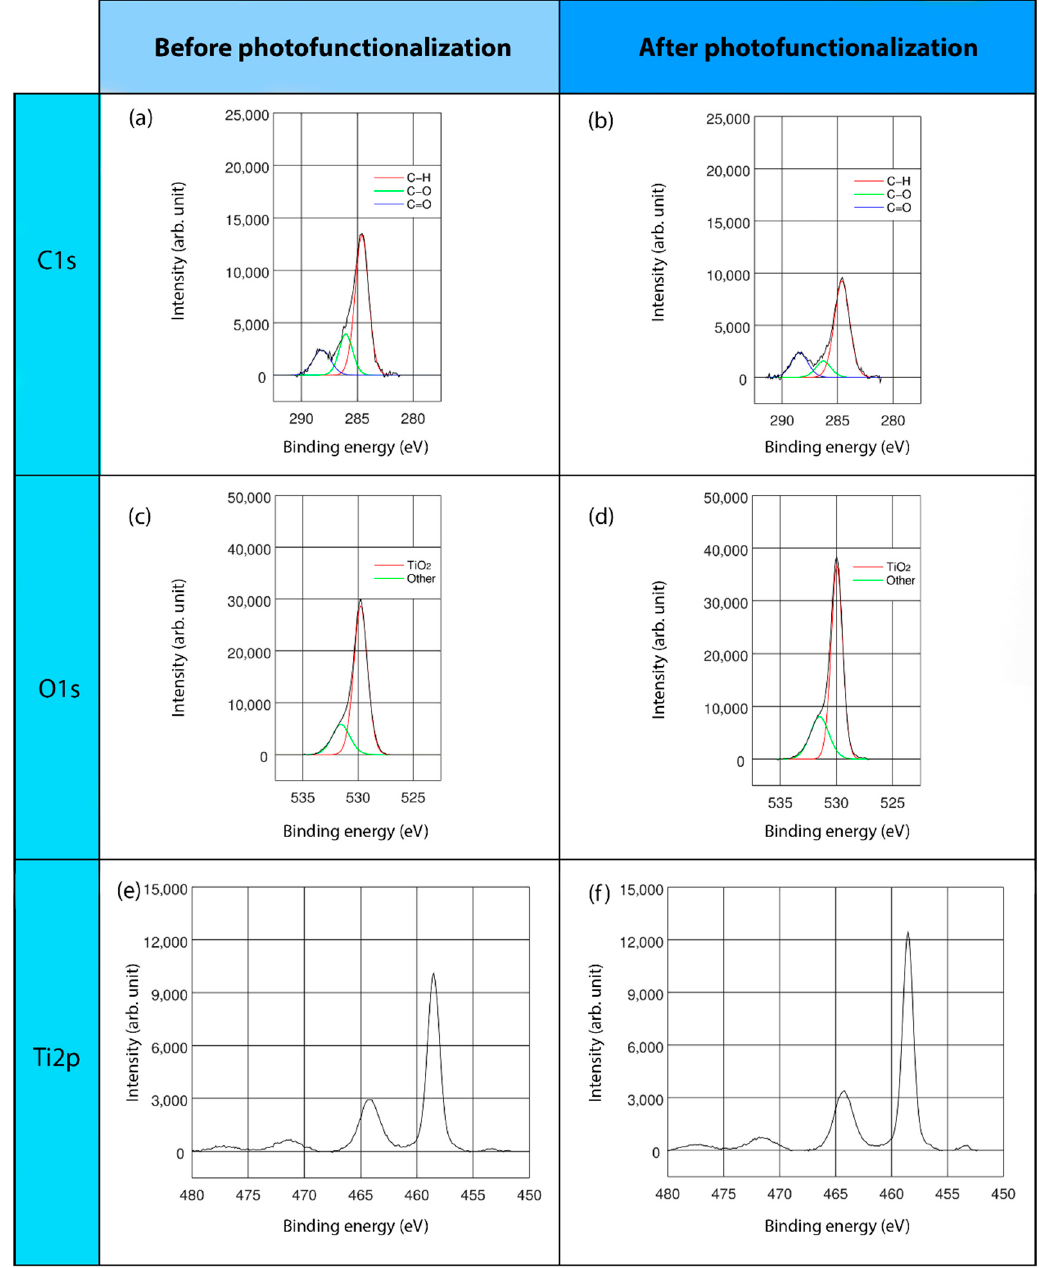
Figure 4. XPS analyses of SLA surface: XPS full-range spectra and deconvoluted XPS, with lines analysis and binding energies of C1s, O1s, and Ti2p; before ( a , c , e ) and after ( b , d , f ) LED-based UVC photofunctionalization.